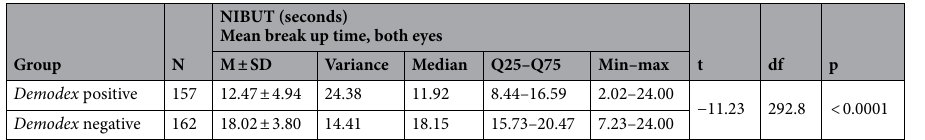
NIBUT (seconds) Mean break up time, both eyes